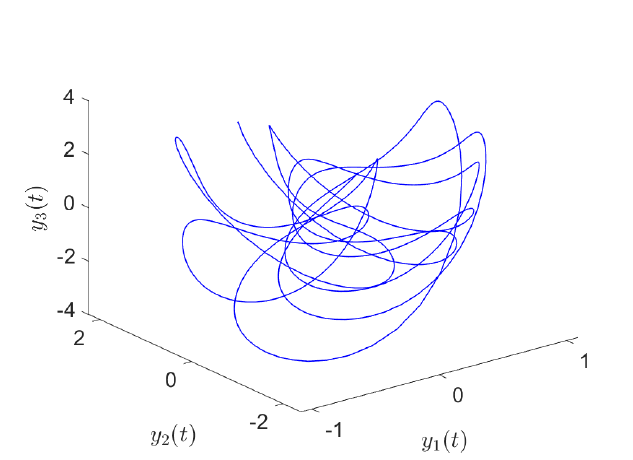
Figure 36. Phase portraits of y 2 and y 3 .